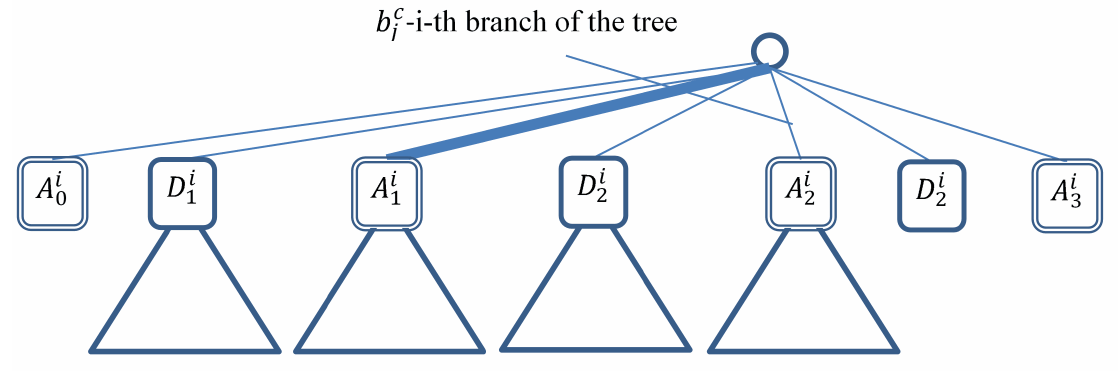
Figure 6. Complex